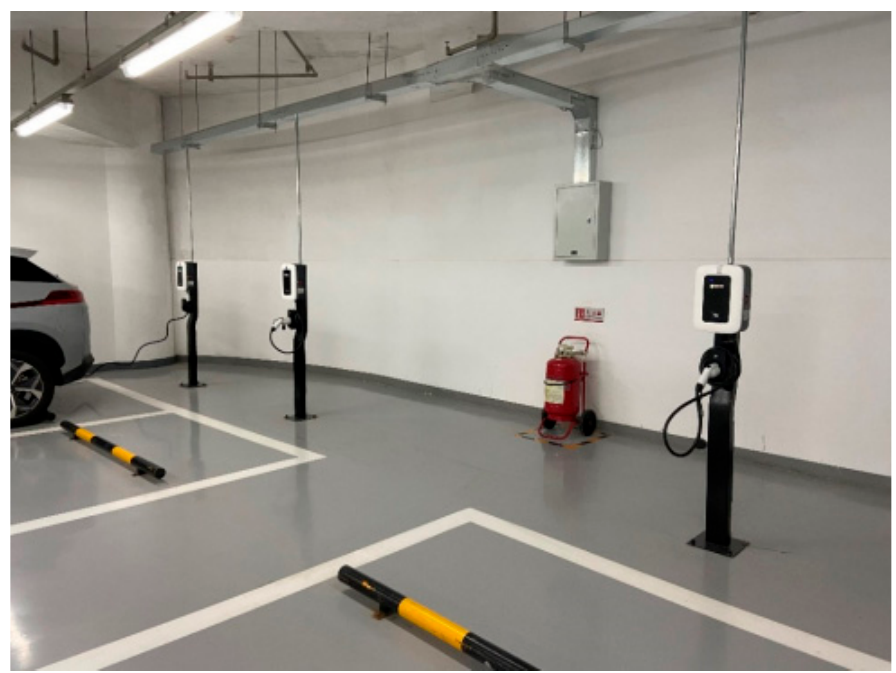
Figure 3. Realistic representation of the installation of EV charging piles.